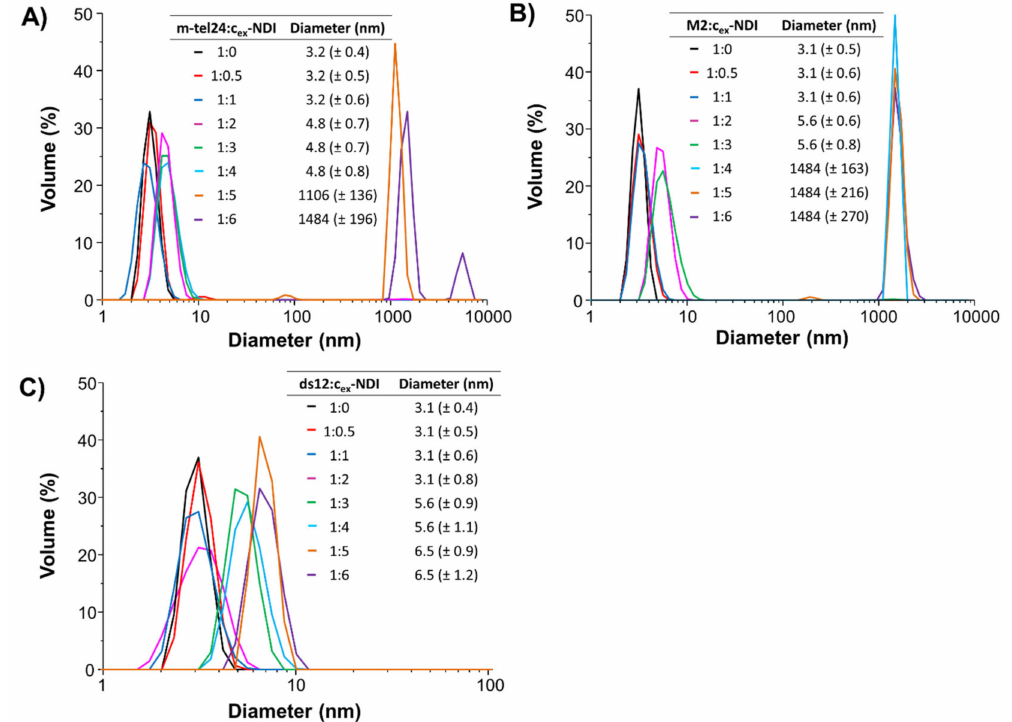
Figure 3. Volume-based particle size distribution for ( A ) m-tel24 G-quadruplex, ( B ) M2 G-quadruplex and ( C ) ds12 duplex in the absence and presence of different amounts of c ex -NDI (from 0.5 to 6 equivalents). Tables report the hydrodynamic size ( ± S.D.) for the different species formed on increasing c ex -NDI